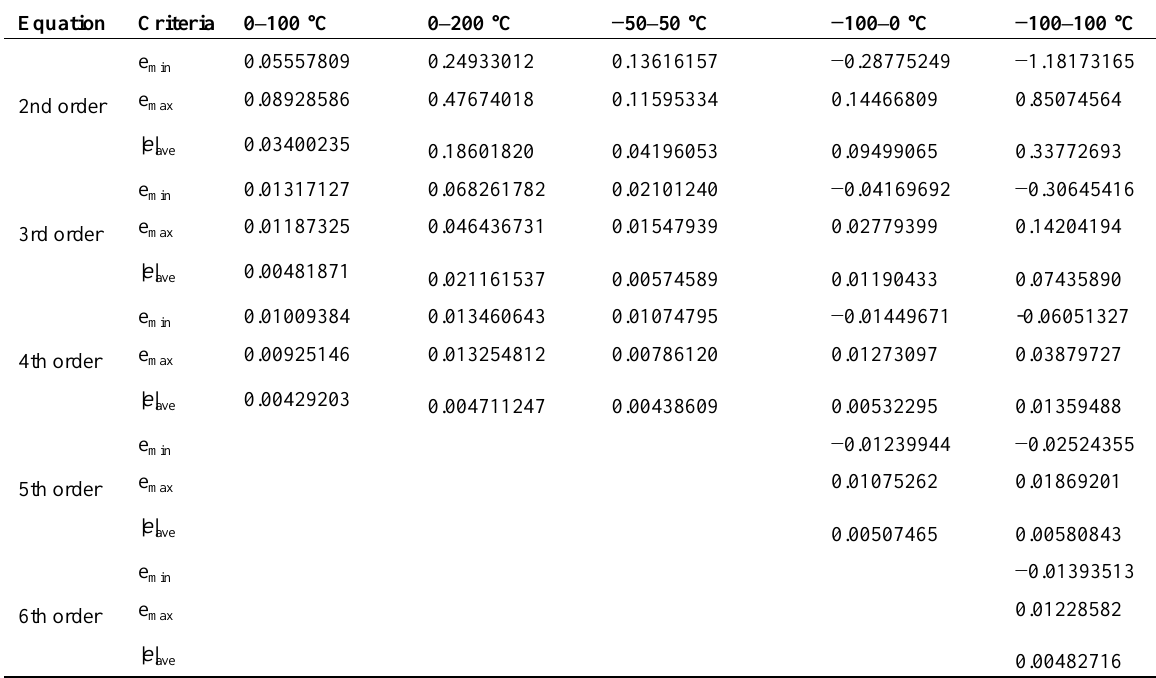
Table 5. Criteria for evaluating of polynomial equations for J-type thermocouples by temperature range.